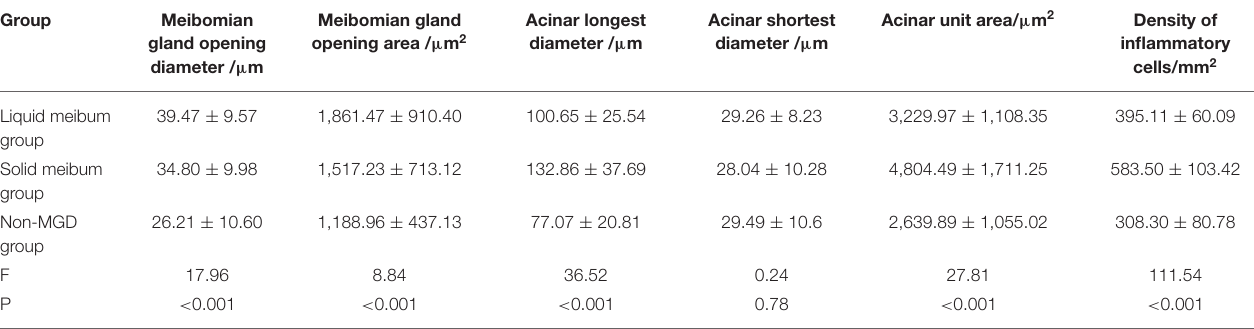
TABLE 1 | Parameters of the meibomian glands under a confocal microscope. Group